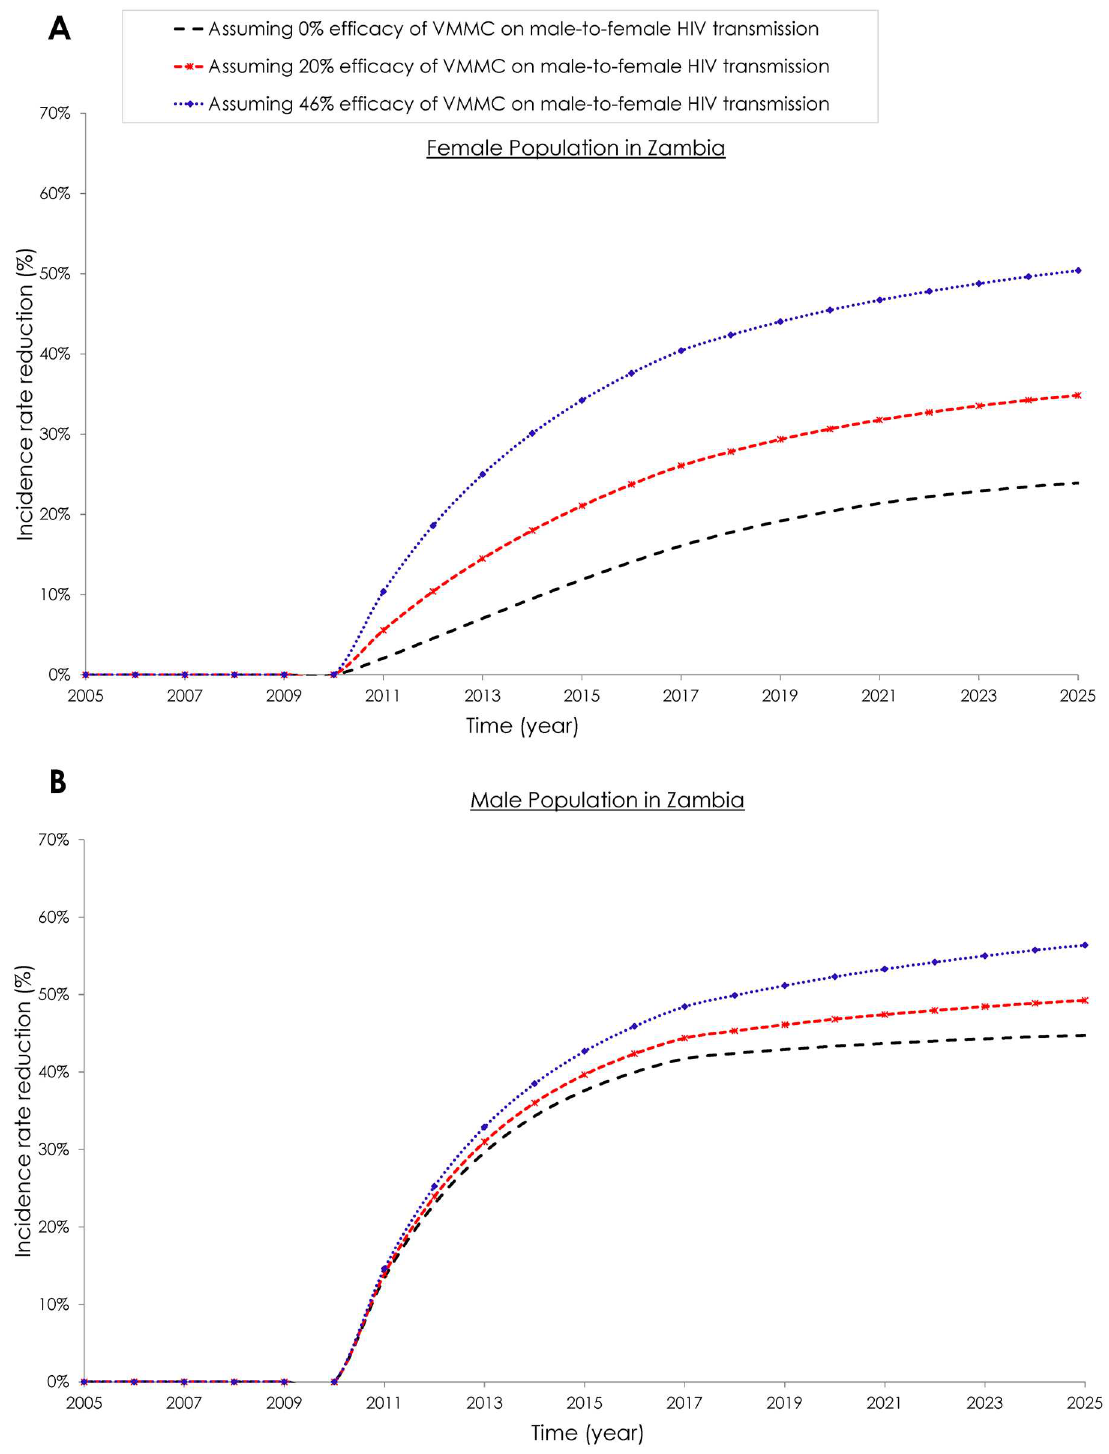
Fig 5. Impact of different male circumcision efficacylevels, against male-to-female HIV transmission, on HIV incidence rate reduction in Zambia. Incidencerate reductionin A) the female population and in B) the male populationwith the VMMC programincludinga proportionof HIV-positivemales, basedon their representation in the population.The panelsassume i ) 0% efficacy, ii ) 20% efficacy, and iii ) 46% efficacy of male circumcision against male-to-female HIV transmission.